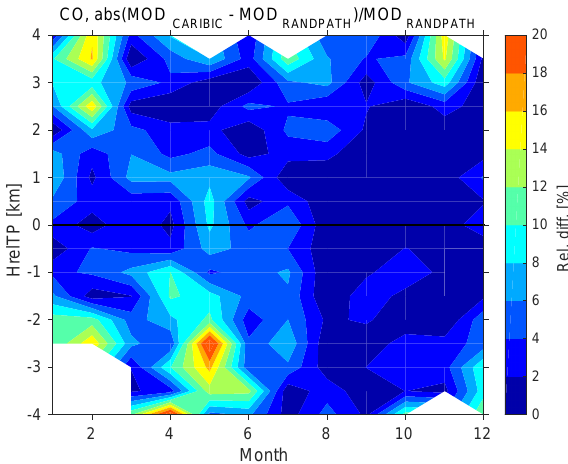
Figure 4. Relative differences of CO for MOD regular MOD RANDPATH . This is the basis used to calculate R rel